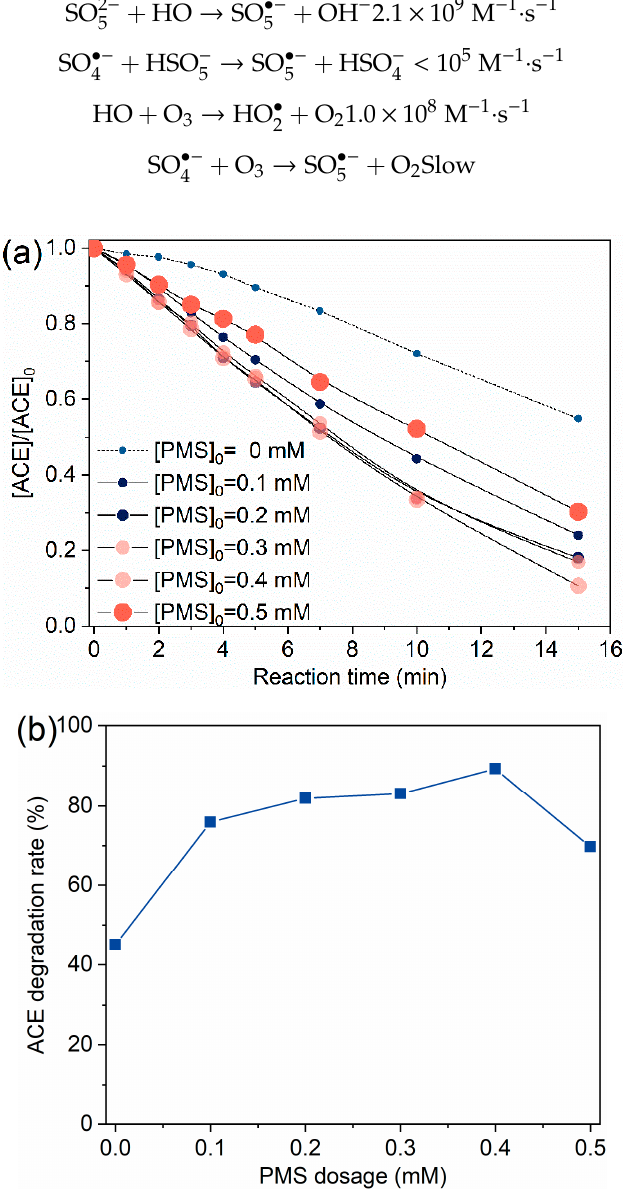
Figure 2. Degradation of ACE by O 3 /PMS at different PMS dosage: ( a ) Evolution of ACE concentration; ( b ) ACE degradation rate vs. PMS dosage. Conditions: [ACE] 0 = 8.0 mg · L − 1 ; pH = 7.4; 15 ± 1 °C; O 3